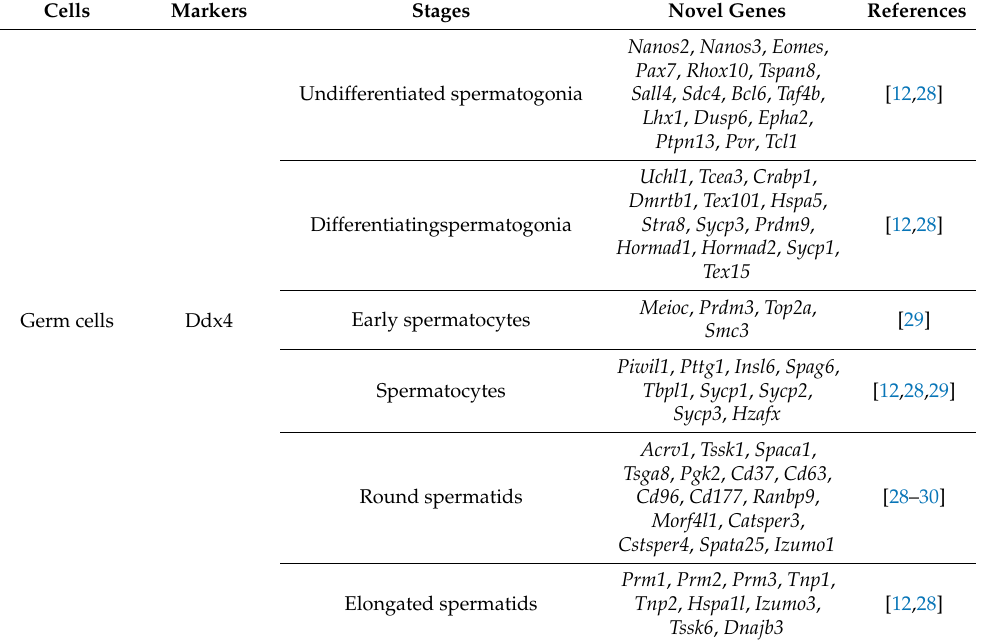
Table 1. Novel genes involved in mouse germ cells by single-cell RNA